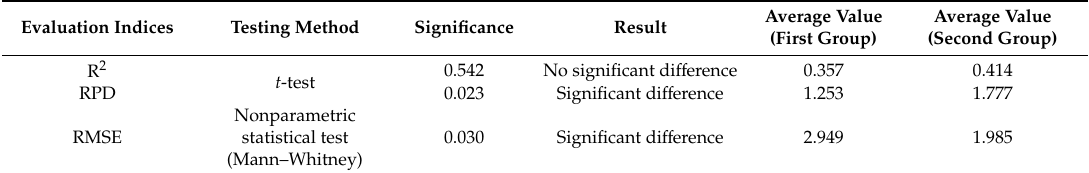
Table 9. Di ff erence test of evaluation indices in single and coupling